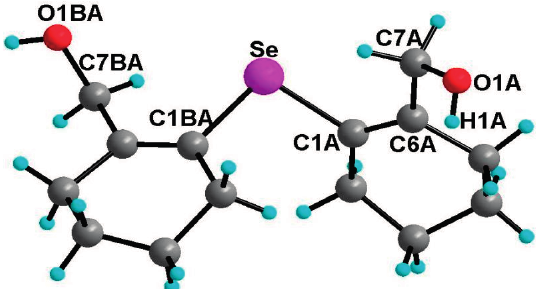
Figure 2. Molecular structure of 19 . Selected bond lengths (Å) and bond angles (°);